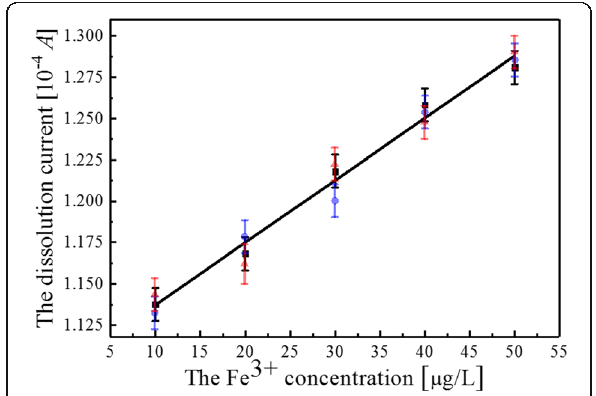
Fig. 6 The current peaks dependence of the Fe 3+ ions concentration